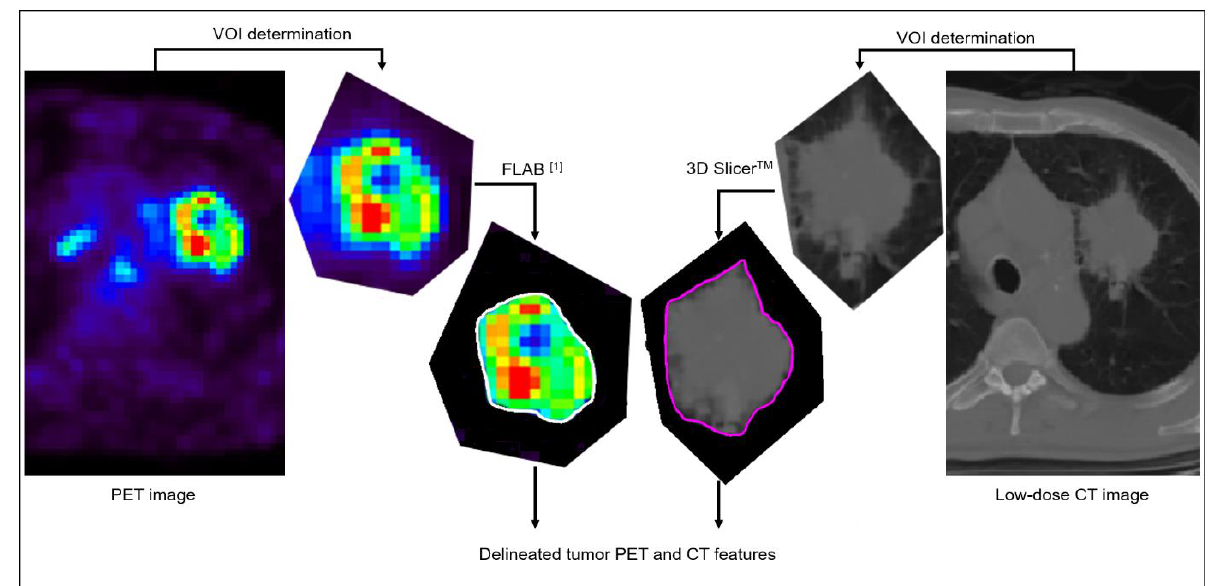
Figure 1. Illustration of the delineation process of PET and CT images of the tumor. After delineation, all volumes of interest for the 138 patients in both PET and CT images were re-processed for radiomic feature extraction, in order to rely on the most up-to-date international Image Biomarker Standardization Initiative (IBSI) recommendations and benchmark values